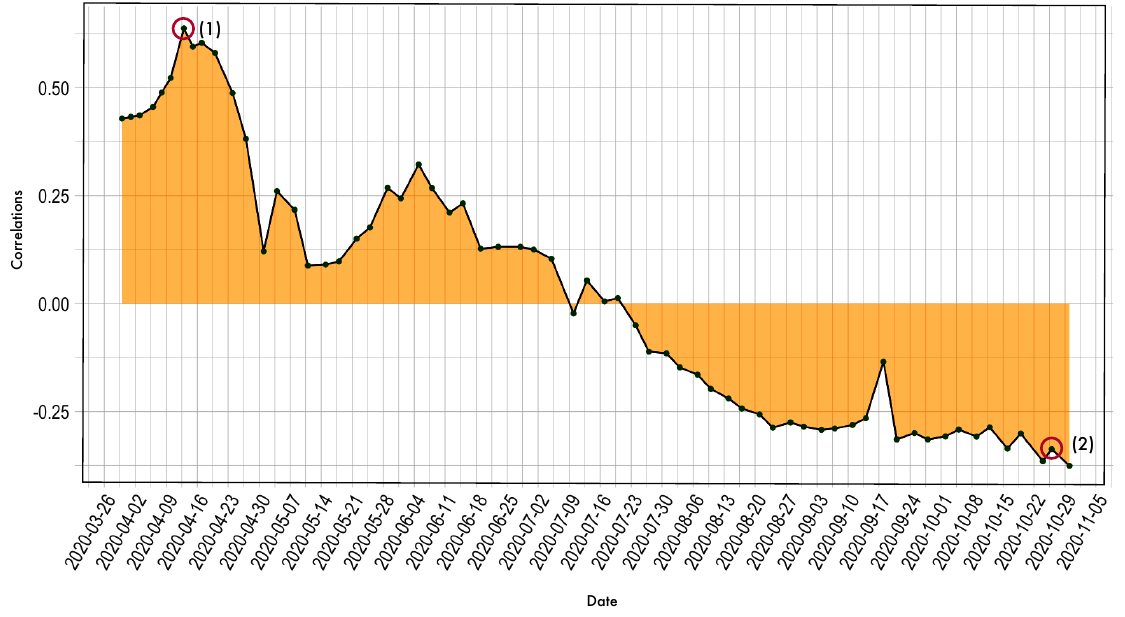
Figure 10. Temporal evolution of the correlation between the mobility index and the cumulative number of COVID-19 cases per 100.000 inhabitants in the period from 26 March to 30 October